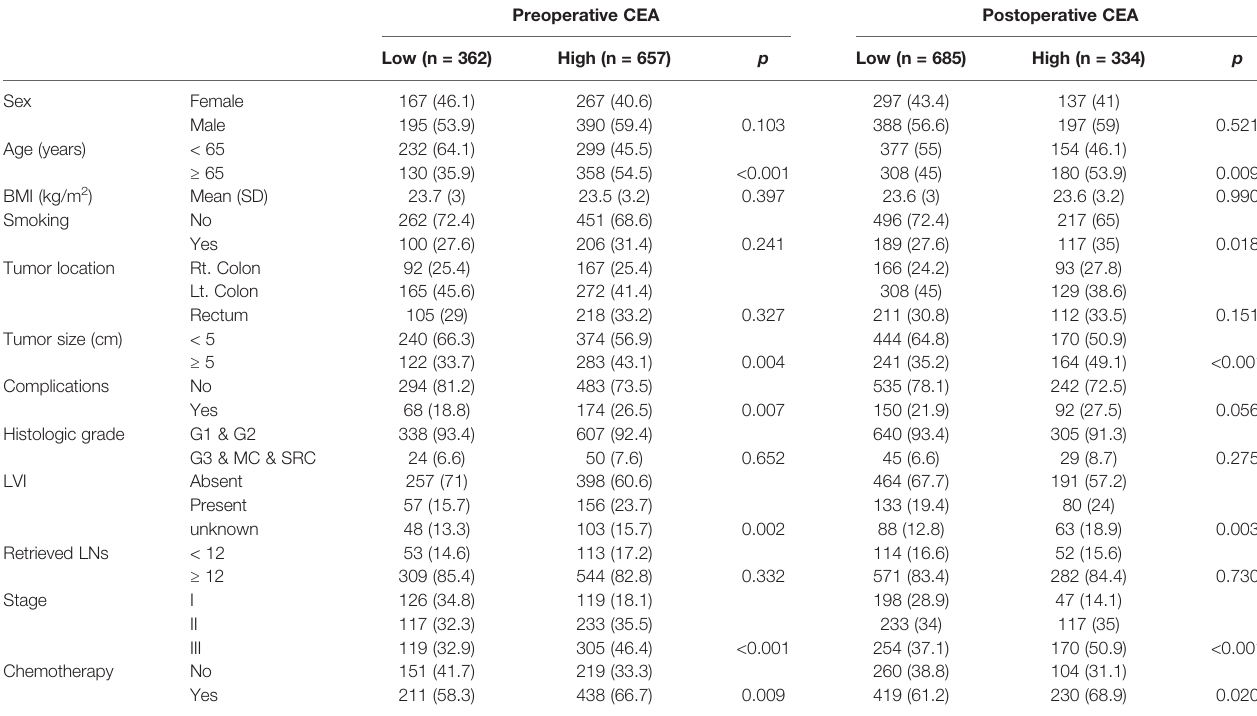
TABLE 1 | Patient characteristics according to